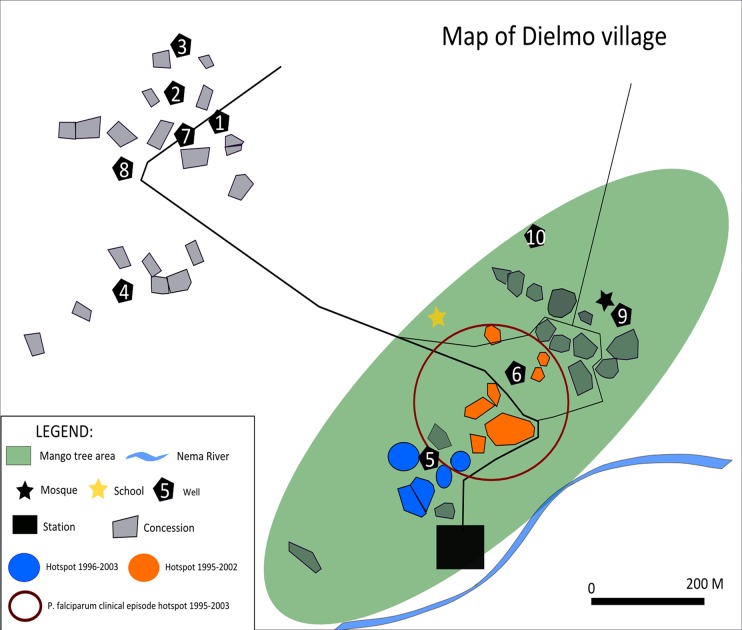
Map of Dielmo village.The village is located at 13°45’N, 16°25’W and is composed of two hamlets showing the houses within the gametocyte hotspots (hotspot 1—blue, 1996–2003, Relative Risk (RR) 1.95, log likelihood ratio (LLR) 14.35 P = 0.0012; cluster 2—green, 1995–2002, RR 1.77, LLR 12.7 P = 0.0053) identified by SaTScan Also shown (large open red circle), area of the P. falciparum clinical episode hotspot identified by SaTScan; 1995–2003, RR 1.42, LLR 11.01 P = 0.026.